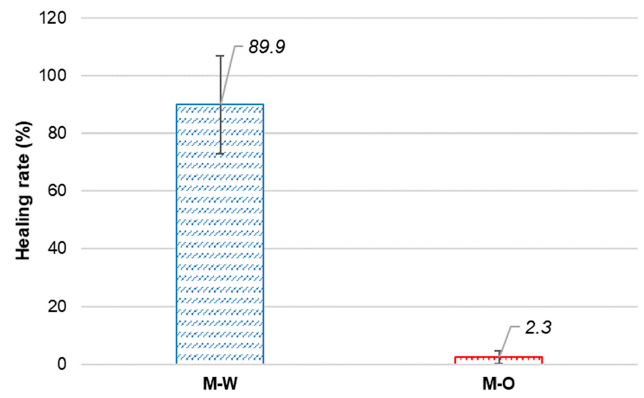
Figure 8. Healing rate of SHCC.